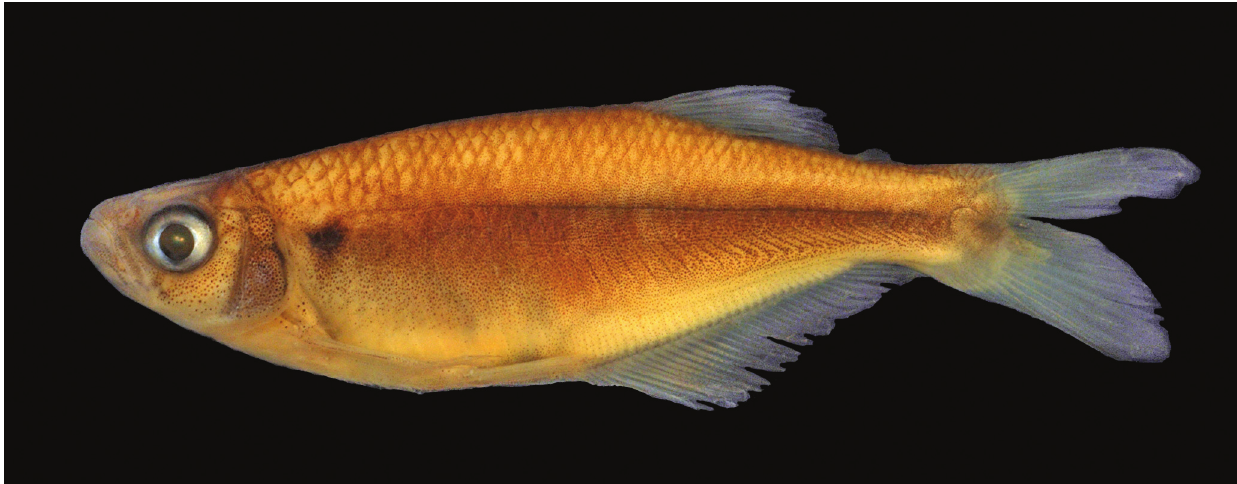
Fig. 1. Chrysobrycon eliasi , holotype, male, MUSM 39970, 34.25 mm SL, Peru, Madre de Dios, Tambopata, río Madre de Dios basin, Creek